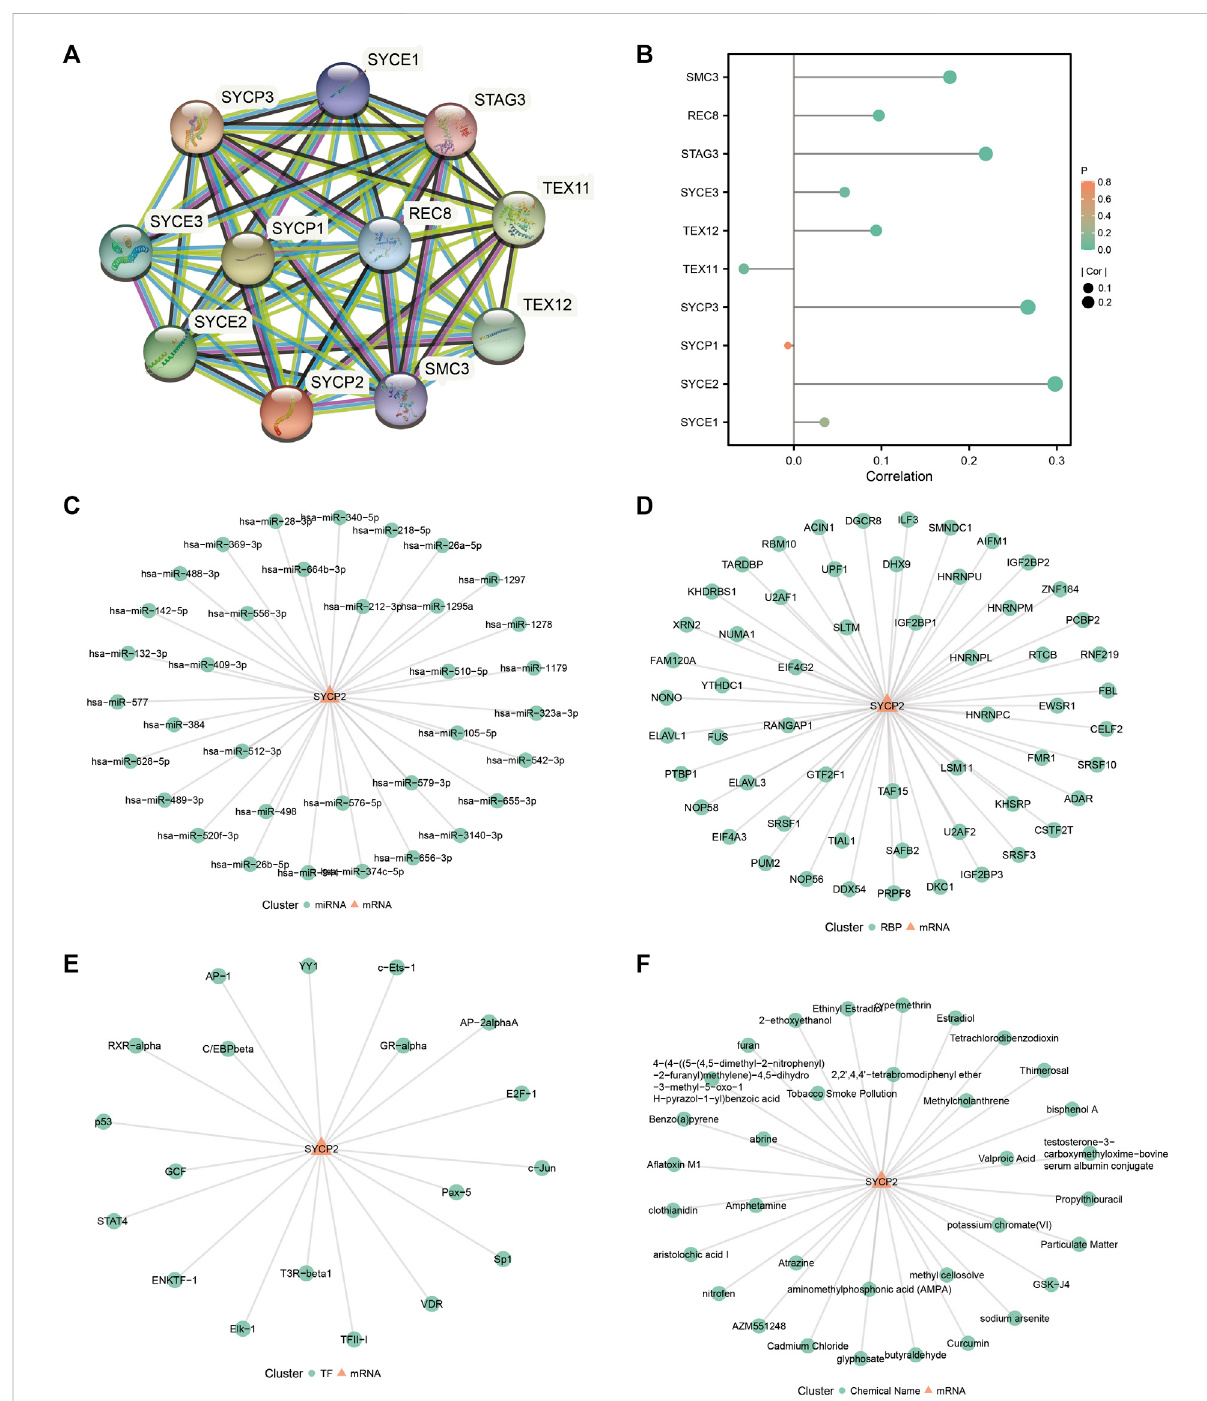
FIGURE 7 Constructionof protein – proteininteraction network and related regulatory network. (A) PPI network of SYCP2 based on theSTRINGdatabase. (B) Lollipop diagram of the relationship of SYCP2 interaction proteins. (C) The mRNA – miRNA network was constructed based on the starBase database. (D) The mRNA – RBP network was constructed based on the starBase database. (E) SYCP2 -transcription factor network was constructed based on the PROMO platform. (F) SYCP2 -chemical drug network based on CDC